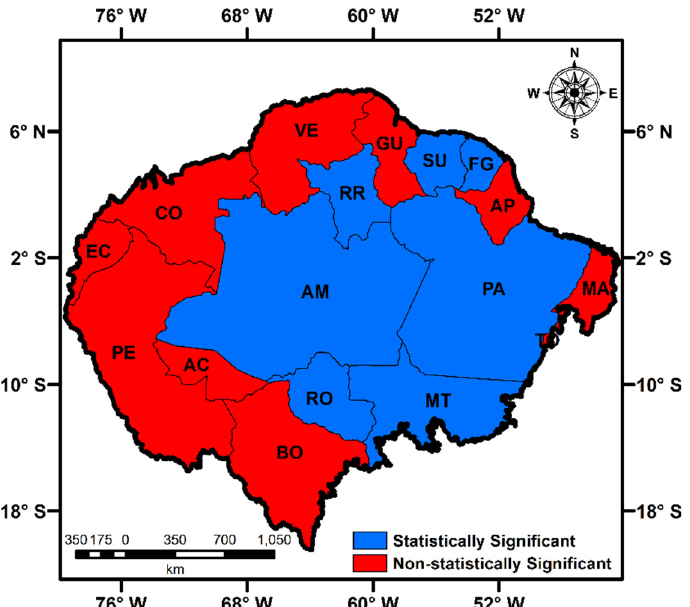
Figure 4. Significance of the correlation between PM 2.5 emitted from biomass burning and deforesta- tion in the Amazonian countries/states. The significance of correlations was tested using the Student t-test with significance level of 5%. BO = Bolivia, CO = Colombia, EC = Ecuador, FG = French Guiana, GU = Guiana, PE = Peru, SU = Suriname, VE = Venezuela, AC = Acre, AM = Amazonas, AP = Amapá, MA = Maranhão, MT = Mato Grosso, RO = Rondônia, RR = Roraima, PA = Pará and TO = Tocantins.